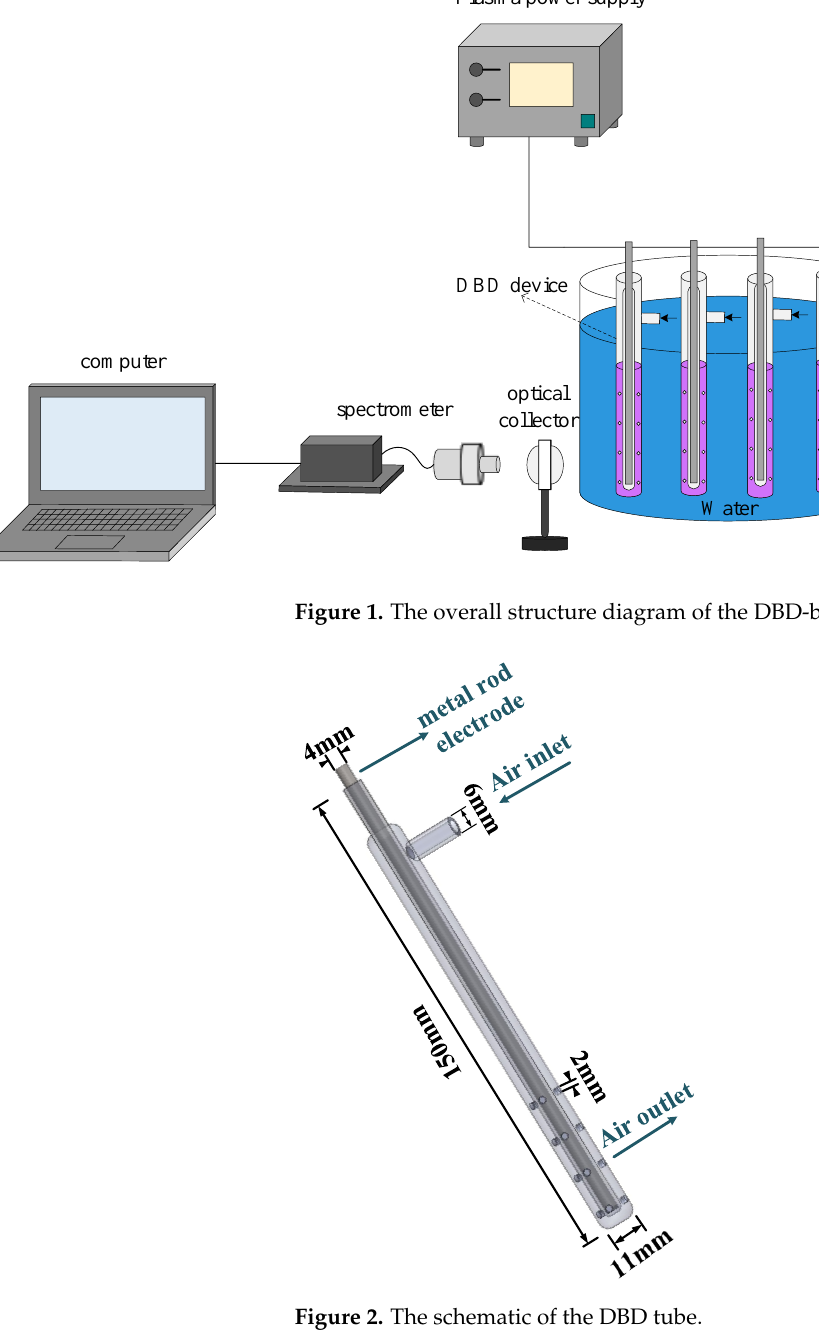
Figure 1. The overall structure diagram of the DBD-based PAW system.